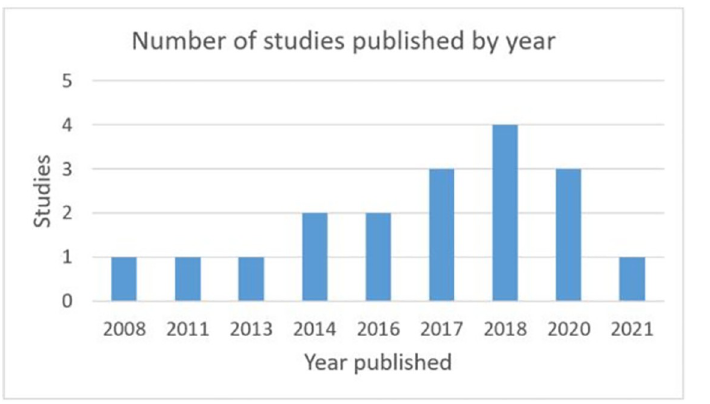
Fig 2. Number of studies published by year.